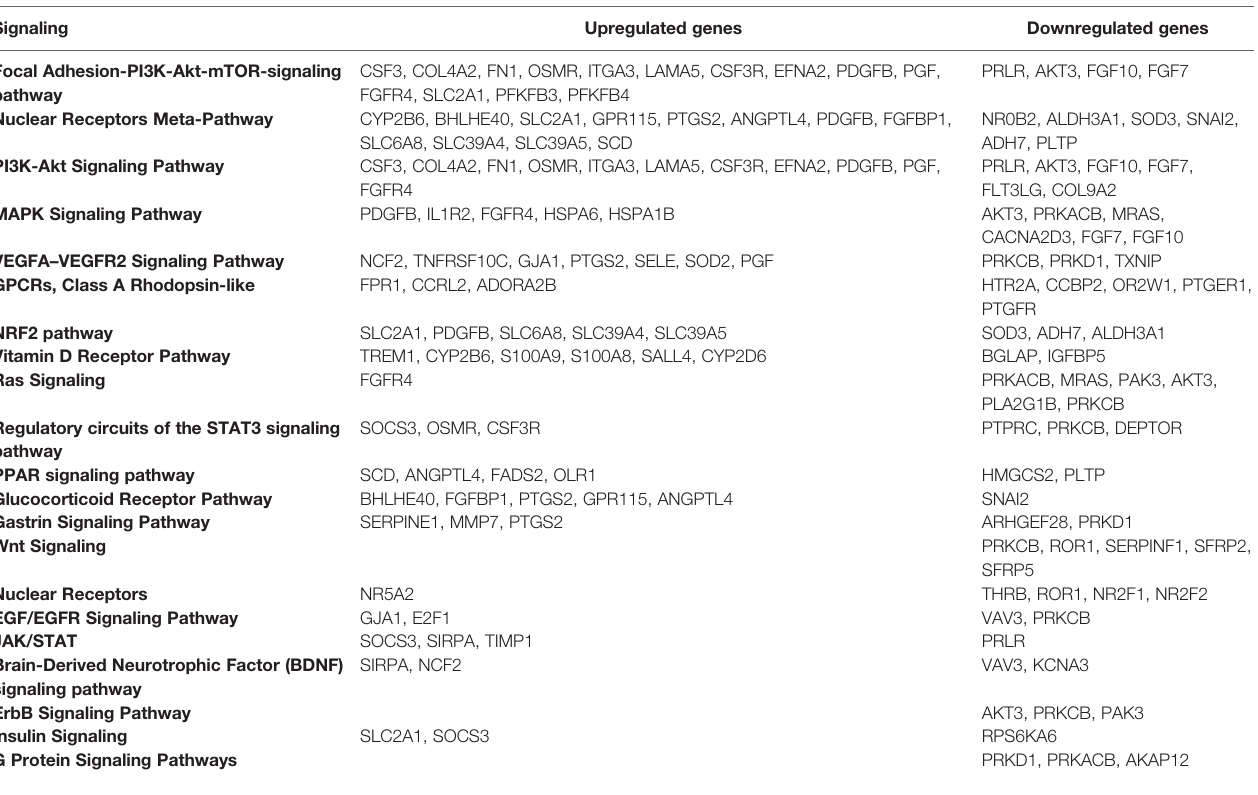
TABLE 4 | Principal pathways of Signaling Cluster for the subset